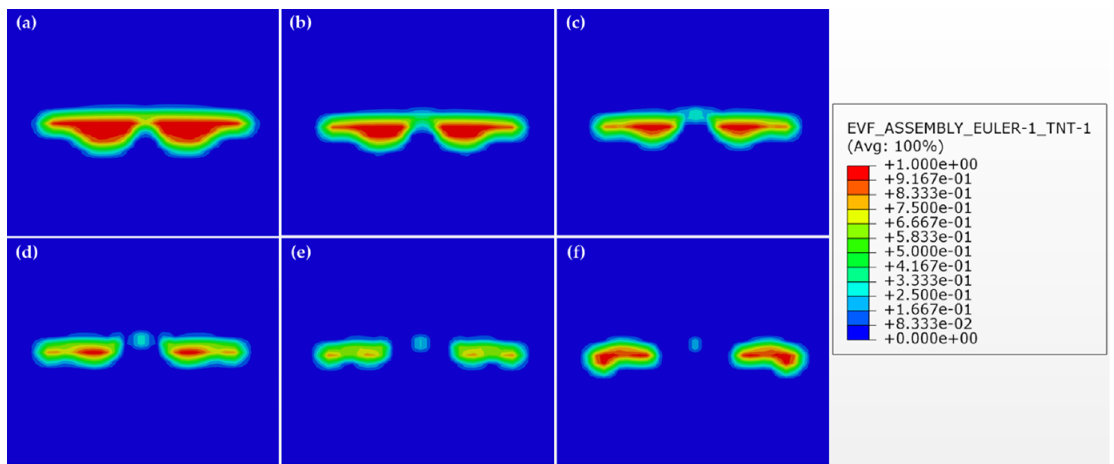
Figure 16. Simulated bubble motion during the collapse phase at: ( a ) t = 7.3 ms; ( b ) t = 7.35 ms; ( c ) t = 7.4 ms; ( d ) t = 7.45 ms; ( e ) t = 7.55 ms; and ( f ) t = 7.9 ms.